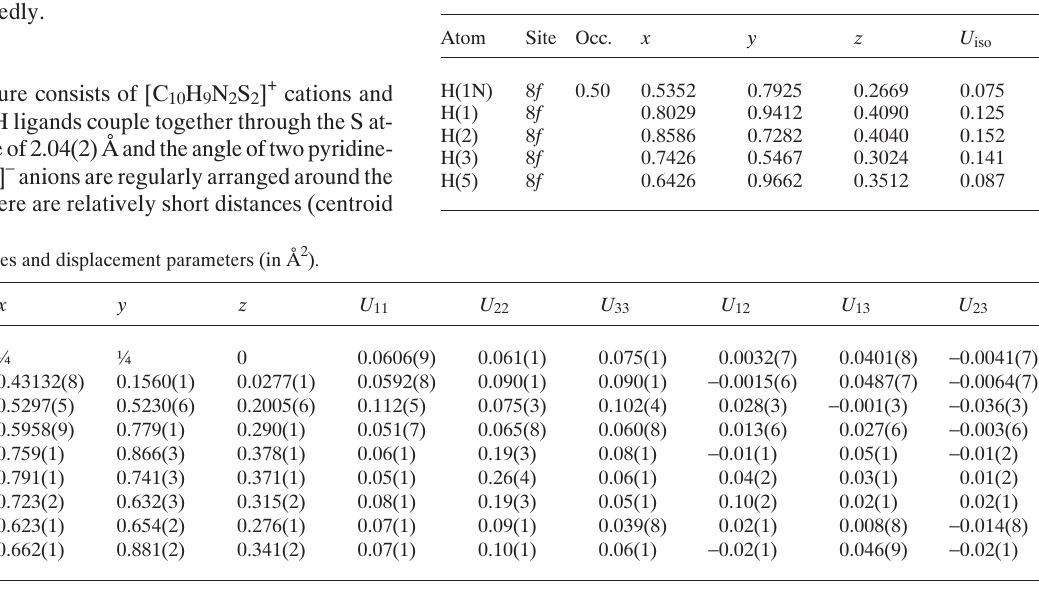
Table 2. Atomic coordinates and displacement parameters (in Å 2 ) .